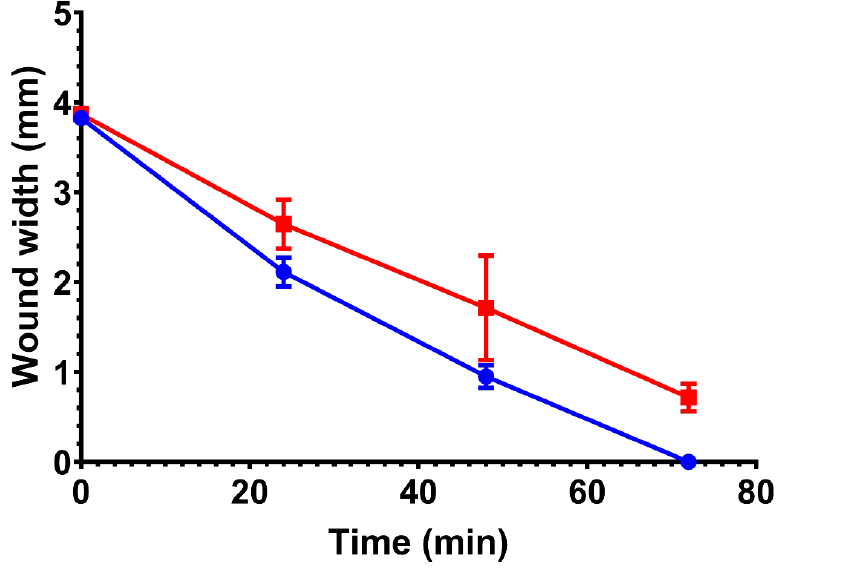
Figure 8. Cell migration test for control group and composite alginate/nano-hydroxyapatite aerogel loaded with tranexamic acid over 72 h.